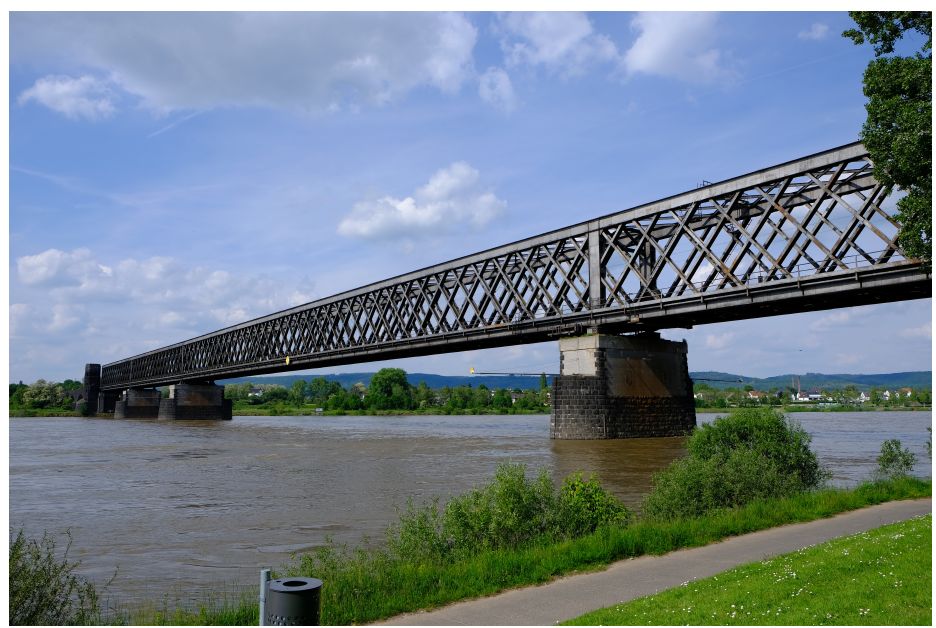
Figure 5. Railway framework bridge under investigation.